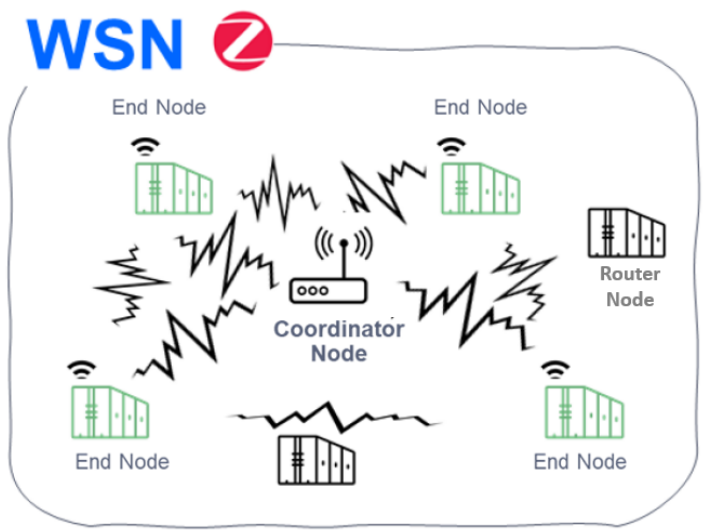
Figure 2. Distribution of node for the WSN